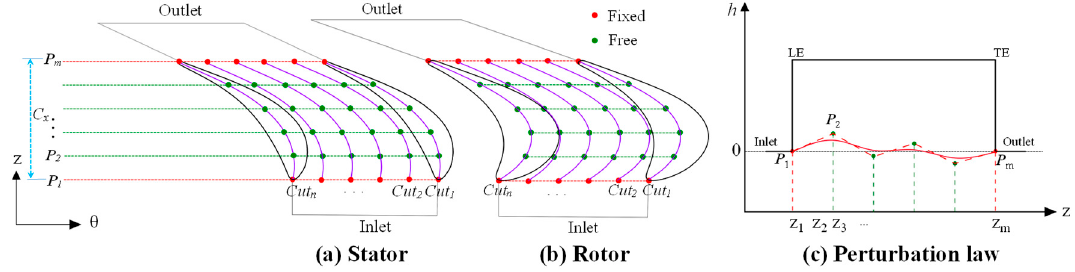
Figure 5. ( a – c ) Control point distribution.